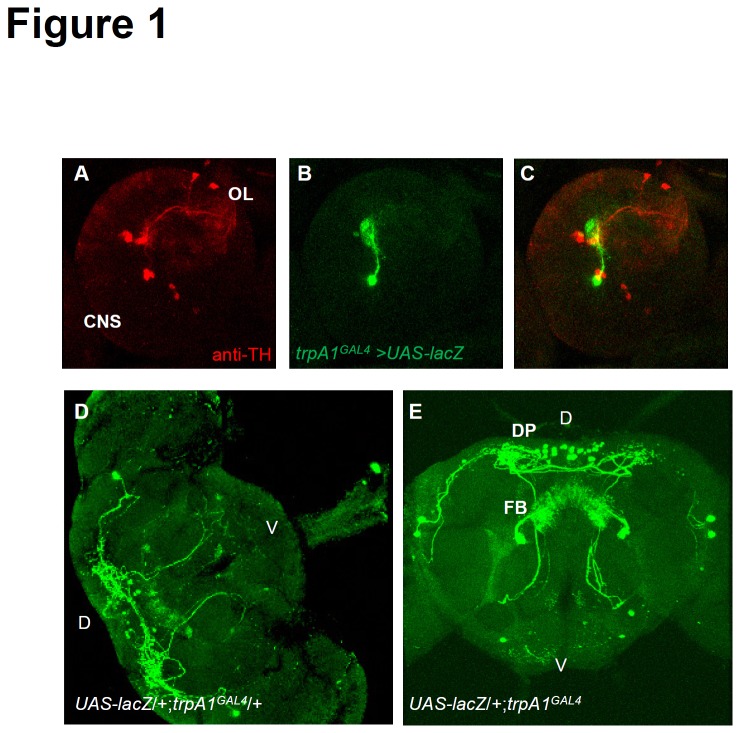
A GAL4 Knock-In into the trpA1 locus illustrates previously unknown expression pattern of trpA1 in the adult brain.(A–C) Brains dissected and stained with anti-TH (A) and anti-β-GAL (B) from UAS-lacZ/+;trpA1
GAL4/+ flies at the third instar larval stage. Merged image (C) indicates no overlap between trpA1 reporter and dopaminergic neuronal marker. (D–E) Brains dissected and stained with anti-β-GAL from UAS-lacZ/+;trpA1GAL4/+ (D) and UAS-lacZ/+;trpA1
GAL4 (E) flies in the adult stage, which indicates the broad expression of the trpA1 reporter and neural innervation of the fan-shaped body (FB) and the dorsal protocerebrum (DP). Abbreviations: D, dorsal; V, ventral.